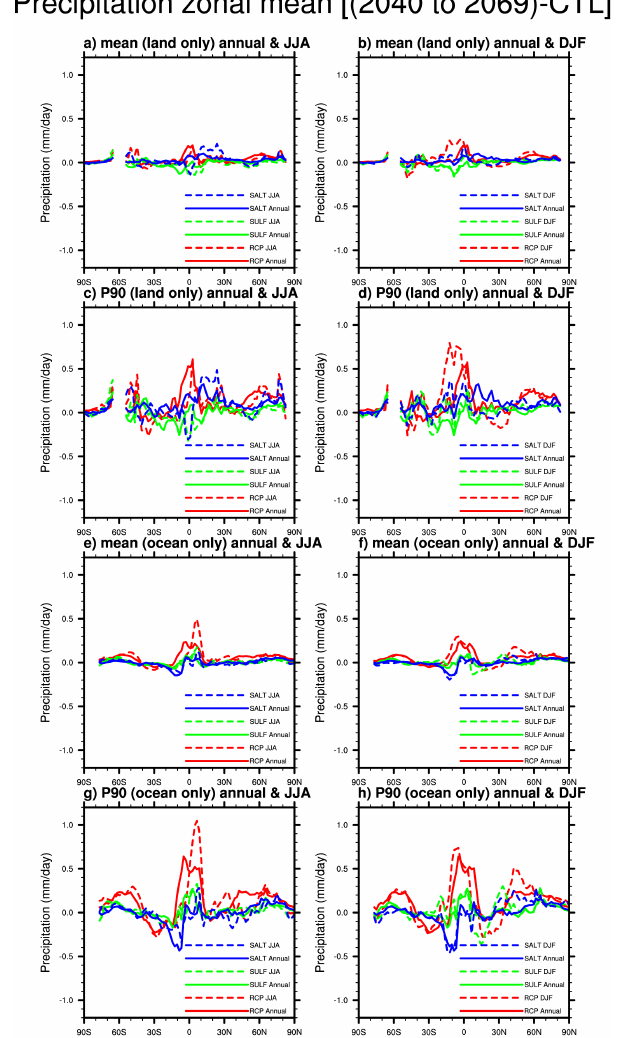
Figure 8. Multi-model zonal mean changes in precipitation (mmday − 1 ) of RCP4.5 (red), SALT (blue) and SULF (green) for the 2040–2069 period minus the RCP4.5 2006–2035 control period (CTL) for annual mean, DJF and JJA periods. Left column for JJA and right column for DJF. First two rows show mean and P90 of land only and the bottom two rows show mean and P90 of ocean only points